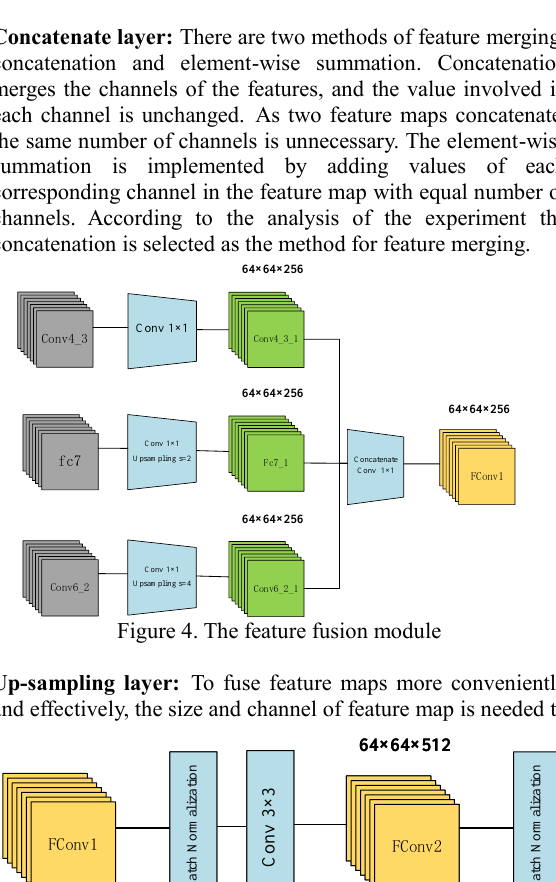
Figure 5. The detection